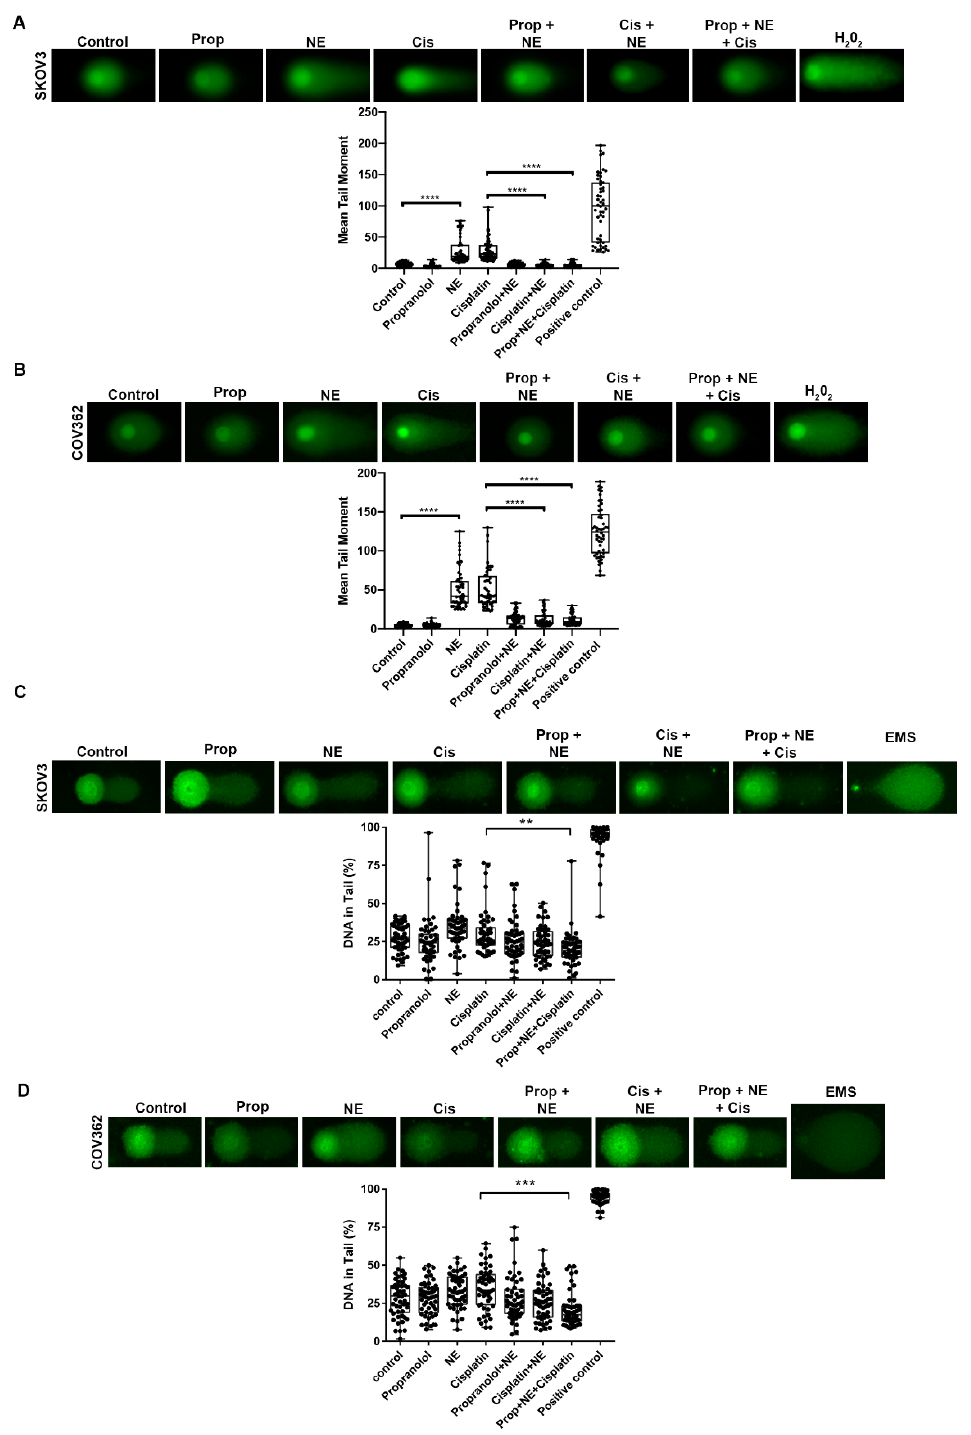
Figure 4. DNA single and double strand breaks after exposure of combination of propranolol, NE, and cisplatin in SKOV3 and COV362 cells. Neutral ( A, B ) and alkaline comet assay ( C, D ) after individual treatment with either NE, cisplatin, or propranolol, and after pre-treatment with propranolol followed by treatment of different agent combinations, for 24 h in SKOV3 and COV362 cells. Double-strand breaks were measured using mean tail moment, and single-strand breaks were measured using the percentage of DNA in tail. Statistical analysis was performed using one-way ANOVA with Dunn’s multiple comparison correction (** p < 0.01, *** p < 0.001, **** p < 0.0001). Data presented is representative of three independent experiments performed in duplicate.